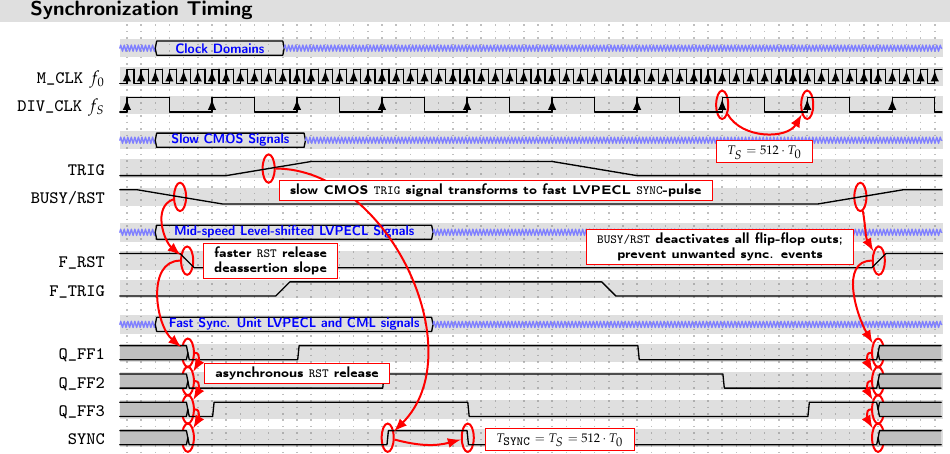
Figure 9. Signal chart for sychronization pulse generation circuit. Note that due to illustration reasons, M_CLK is not shown at the correct scale. One cycle of DIV_CLK actually covers 512 cycles of M_CLK ( T S = 512 · T 0